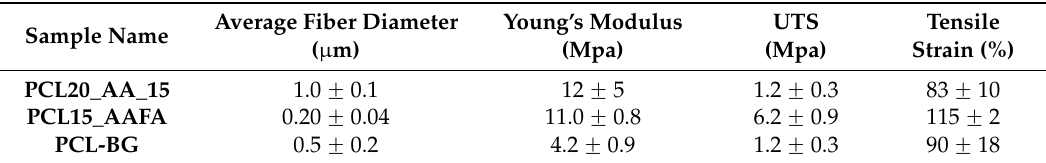
Table 2. Average fiber diameter and mechanical properties of the electrospun mats. UTS: ultimate tensile strength.